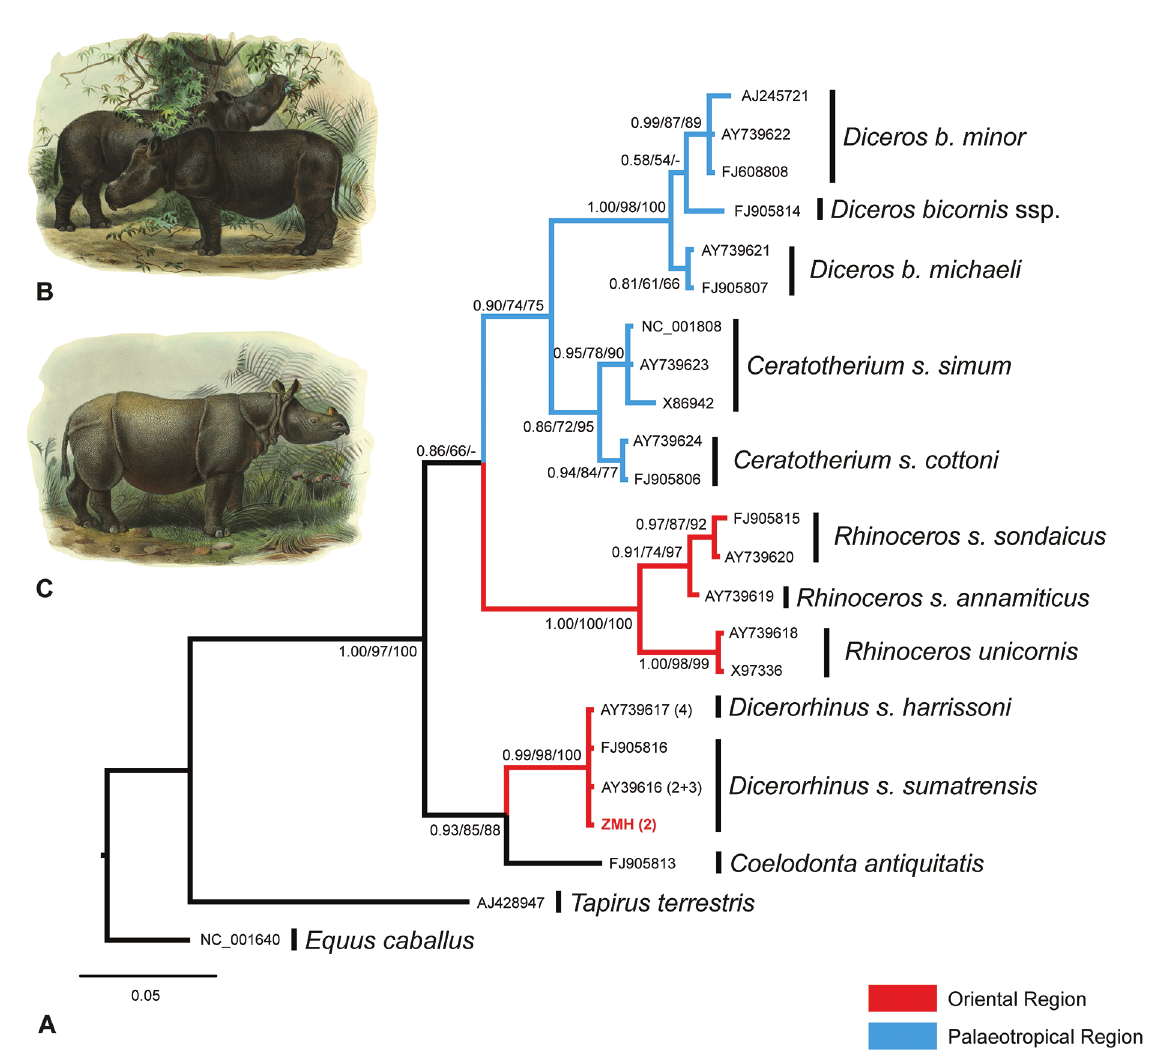
Figure 4. Phylogenetic tree of Rhinocerotidae based on mitochondrial sequences and habitus of Southeast Asian rhinoceroses. A: Bayesian 50% majority consensus tree based on 12S rDNA sequences. Posterior probabilities from Bayesian inference (left) and bootstrap support values (≥ 50%) from the maximum likelihood (middle) and maximum parsimony (right) analyses are indicated at the nodes. B, C: chromolithographies of the Sumatran rhinoceros ( Dicerorhinus sumatrensis ; B) and the Javan rhinoceros ( Rhinoc- eros sondaicus ; C), modified from Sclater